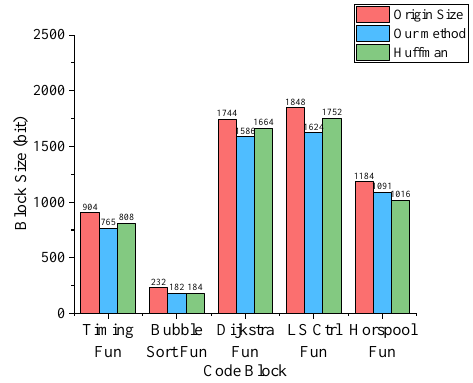
Figure 7. Compressed code size.